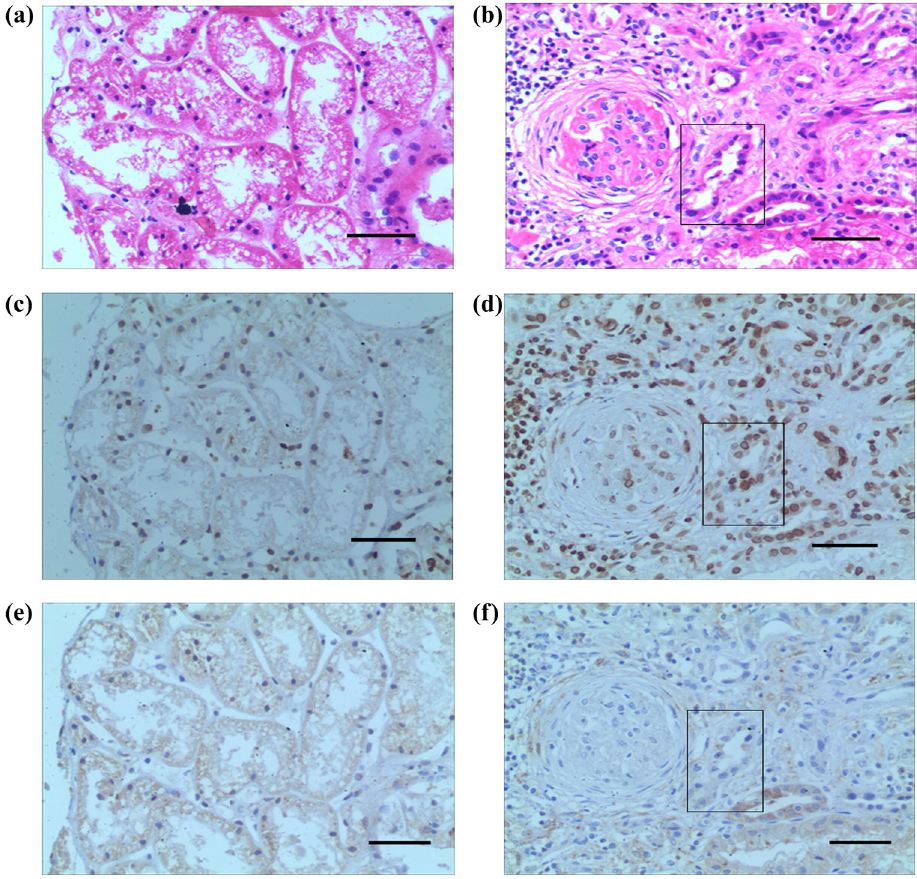
Figure 2: Expression of RAB7 protein in human renal biopsy specimens. ( a ) HE staining was used where there was no fi brosis. ( b ) The expression of HIF - 1 α was detected where there was no fi brosis. ( c ) The expression of RAB7 was detected where there was no fi brosis. ( d ) HE staining was used in the fi brotic area ( displayed in the box ) . ( e ) The expression of HIF - 1 α was signi fi cant in the fi brotic area ( displayed in the box ) . ( f ) The expression of RAB7 was not a ff ected by fi brosis ( displayed in the box )